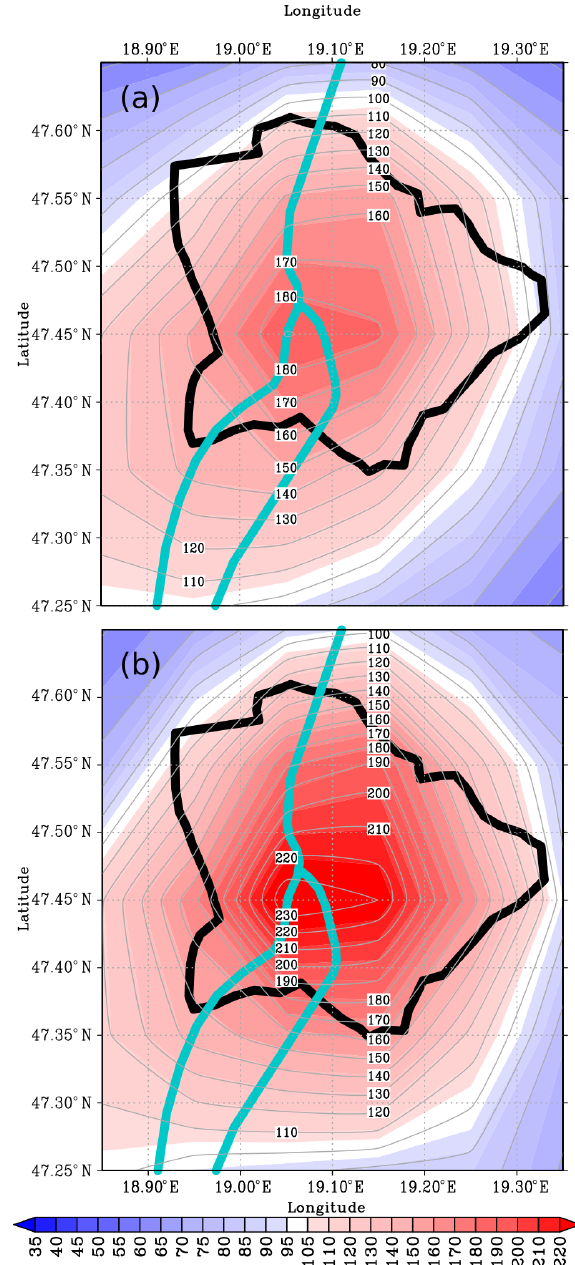
Figure 8. Spatial distribution of median NO concentration in Bu- dapest in 2018–2019 (a) and 2020 (b) during the Restriction phase of the first COVID-19 outbreak obtained from CAMS ensemble re- analysis. The concentrations were normalised to the overall spatial median concentrations of 0.93 and 0.59µgm − 3 , respectively. The border of the city and the Danube River are indicated with curves in black and blue colours, respectively, for better